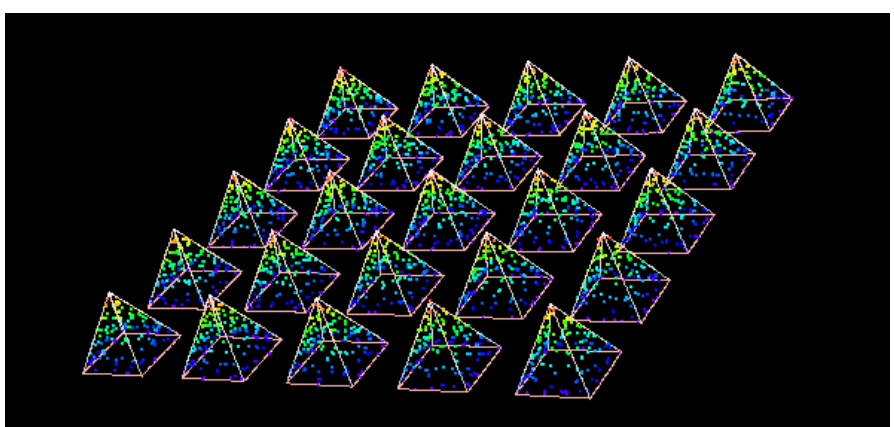
Figure 10. Examples of pyramid array created from airborne lidar simulator.